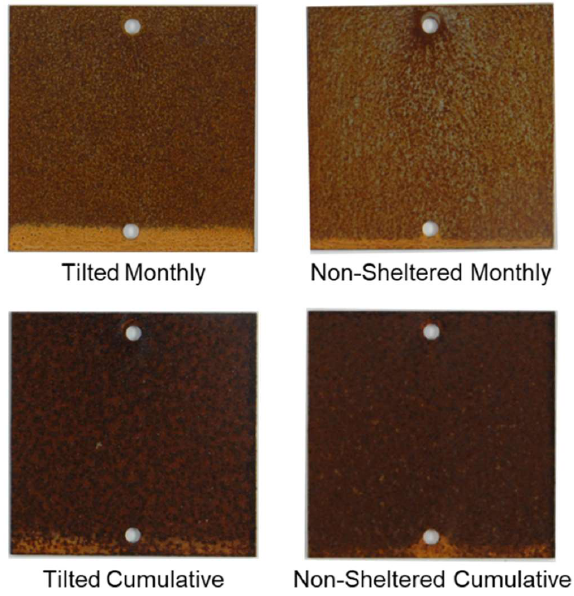
Figure 11. Representative optical images of monthly and cumulative samples in the Tilted and Non-Sheltered condition.